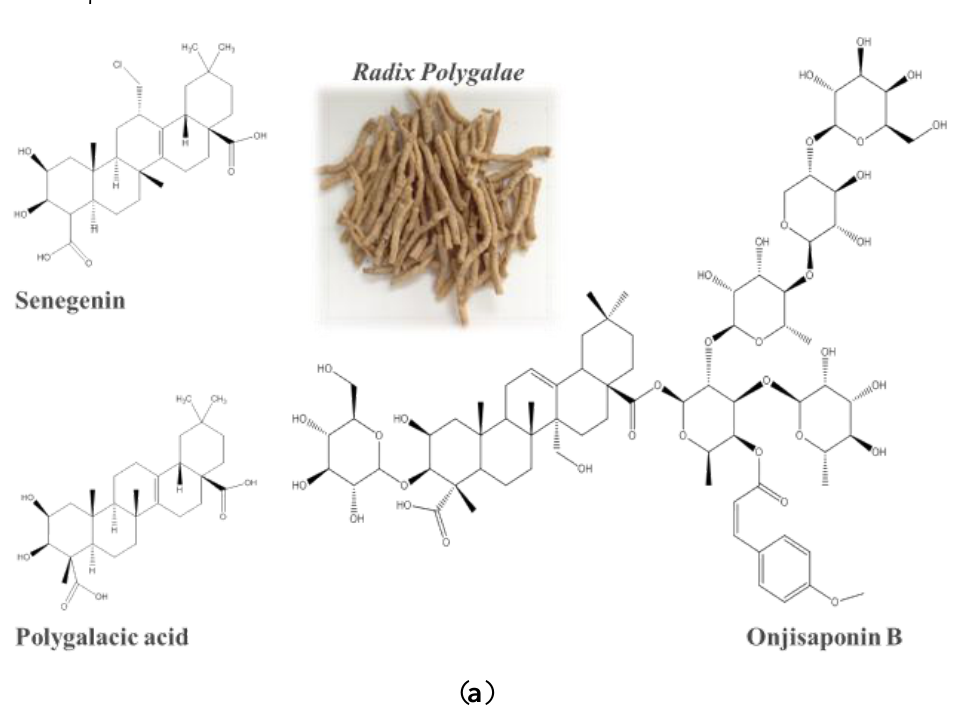
Figure 4. Onjisaponin B as a novel autophagy inducer. ( a ) Chemical structure of polygalacic acid, senegenin and onjisaponin B; ( b ) Cytotoxicity of polygalacic acid, senegenin, onjisaponin B and Radix Polygalae crude extract against PC-12 cells after 48 h of drug treatment; ( c ) PC-12 cells transfected with GFP-LC3 plasmids were incubated with polygalacic acid (50 μM), senegenin (50 μM), rapaymcin (0.3 μM) and 0–50 μM of onjisaponin B (Onji B) for 24 h. Left : representative images with GFP-LC3 puncta formation (magnification, ×40); right : bar chart indicated the percentage of cells with GFP-LC3 puncta formation under these treatments; bars, S.D. *** p < 0.001; ( d ) PC-12 cells were treated with polygalacic acid (50 μM), senegenin (50 μM) and 0–50 μM of onjisaponin B for 24 h. Lower : onjisaponin B (25 μM) was treated with the presence of lysosomal protease inhibitors (10 μg/mL) for the indicated time. Cell lysates were then harvested and analyzed for LC3 I/II and β-actin, respectively; ( e ) PC-12 cells were stained with crystal violet for cell visualization after 24 h of onjisaponin B treatment at the indicated concentrations. Bright field images were captured (magnification, ×4). Columns, means of three independent experiments; ( f ) The mass spectrum of onjisaponin B and Radix Polygalae ethanol extract. All samples were analyzed by UHPLC-MS/TOF and separated on an Agilent Zorbax Eclipse Plus C-18 (50 mm × 2.1 mm) column (particle size: 1.8 μm) at a flow rate of 0.35 mL min −1 . The data was acquired in the scan mode from m / z 100–1700 Da with 2.0 spectra/s. ( A ): The Total Ion Chromatogram (TIC) of onjisaponin B in the standard solution; ( B – D ): The TIC of three different batch of Radix Polygalae ethanol extracts; ( E ): The Extracted Ion Chromatogram (EIC) of onjisaponin B in the standard solution; ( F – H ): The EIC of onjisaponin B in the corresponding TIC ( B – D ) of three different batch of Radix Polygalae ethanol extracts. Scale bar: 15